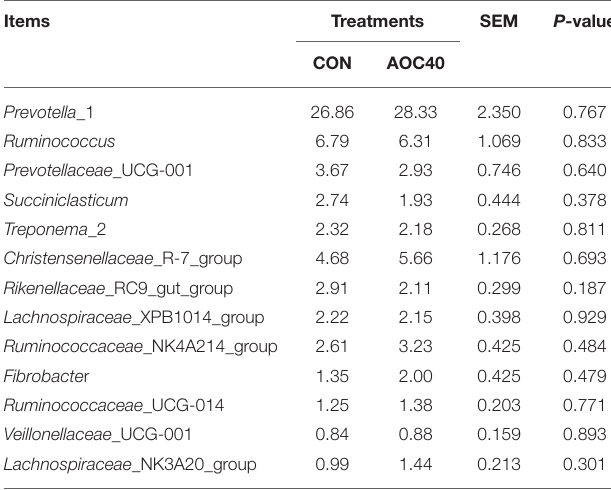
TABLE 7 | Effects of Aspergillus oryzae culture supplementation on the genus-level average relative abundance (% of total reads) of bacteria genus of rumen microbial community of Hu sheep (%).